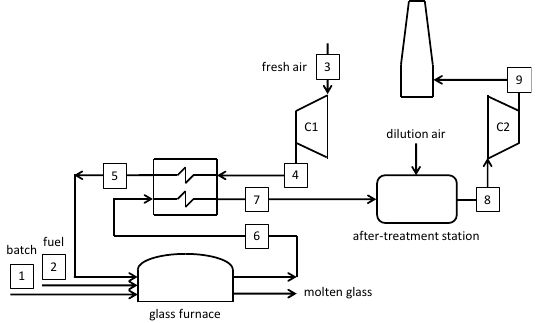
Figure 11. Schematic of the air-blown reference furnace.